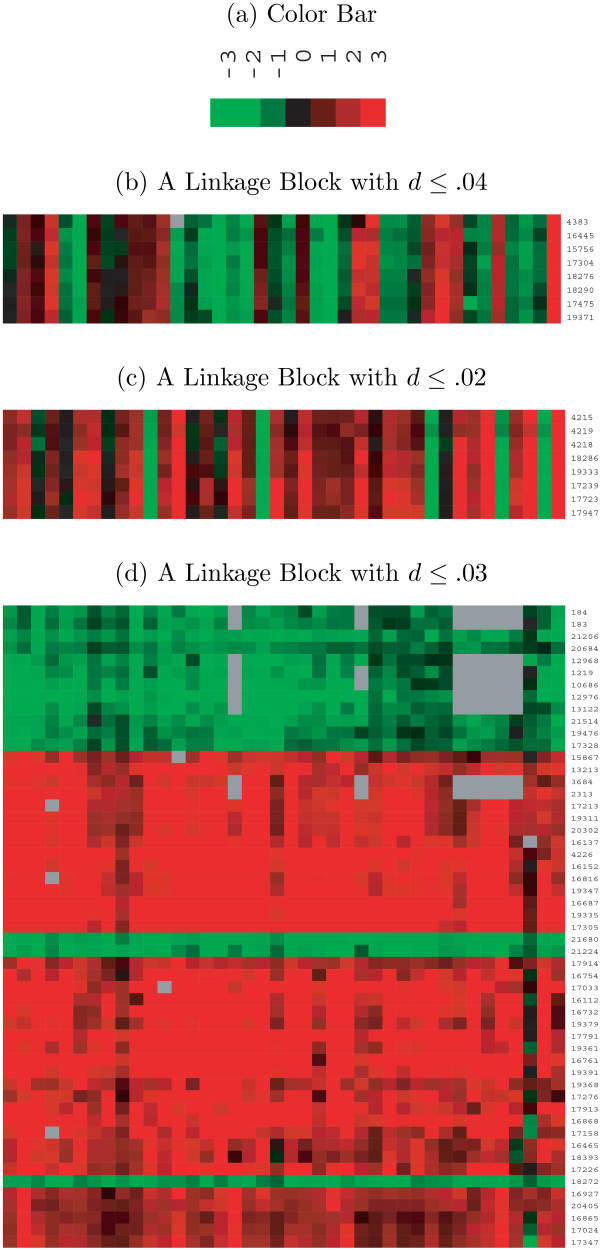
Illustration of Linkage Blocks. Part (a) indicates the color bar used in the other parts. Parts (b), (c) and (d) represent three different linkage blocks with correlation coefficients being 0.96, 0.98, and 0.97 respectively, where each row corresponds to a gene and each column corresponds to an individual.